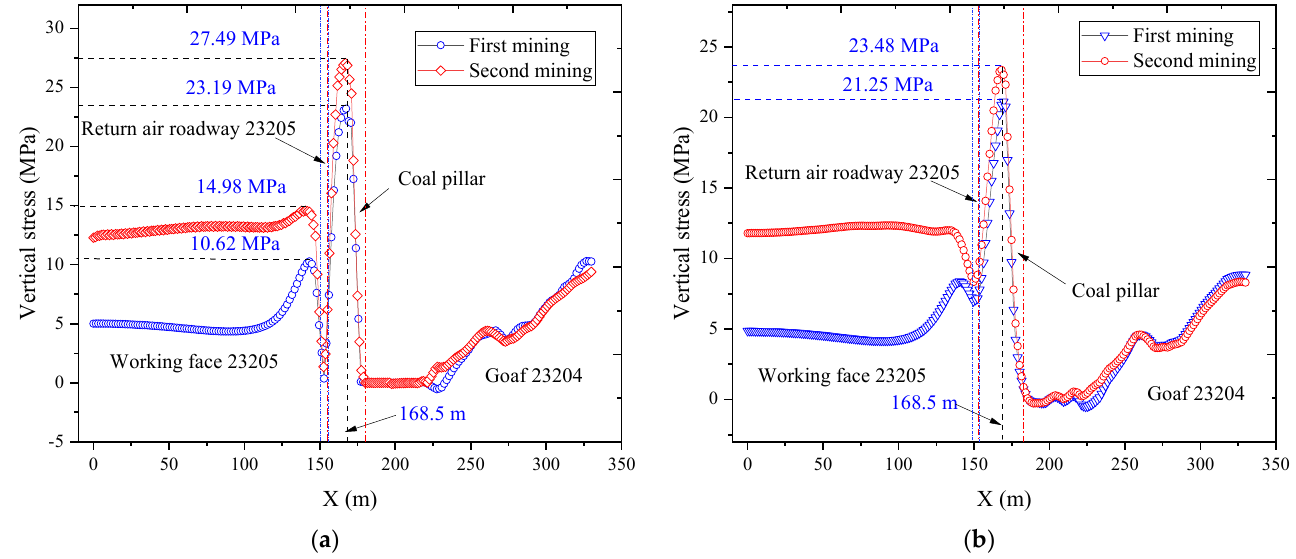
Figure 11. Stress evolution law of surrounding rock during the second mining of working face 23205: ( a ) the vertical stress distribution in the middle sidewalls of RAR 23205; ( b ) the vertical stress distribution 2 m along the roof of RAR 23205.